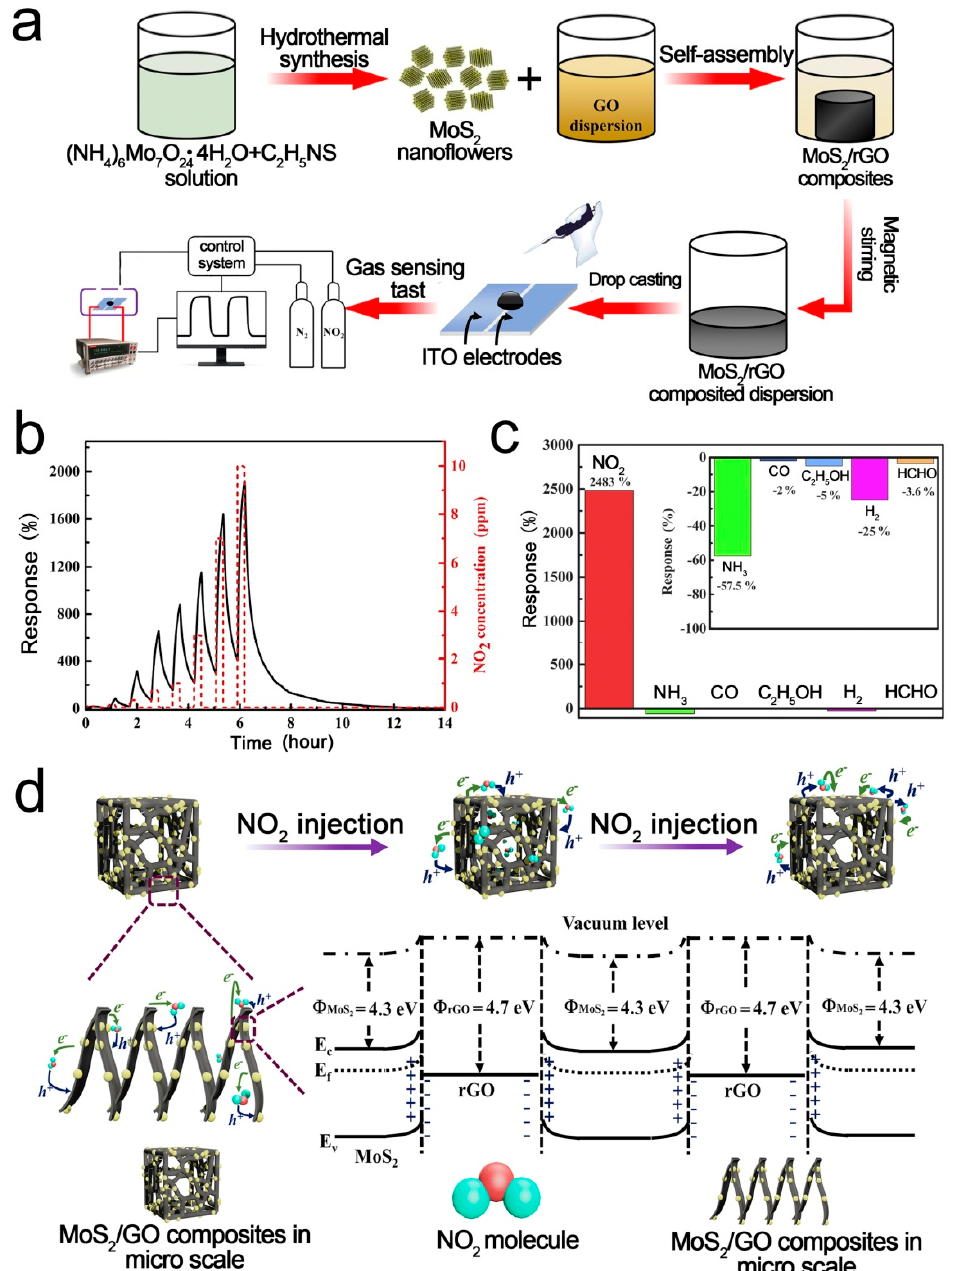
Figure 2. ( a ) Fabrication process of 3D MoS 2 /RGO; ( b ) Dynamic gas responses of MoS 2 /RGO; ( c ) Responses of MoS 2 /RGO-5; ( d ) Schematic illustration of the sensing mechanism [52].